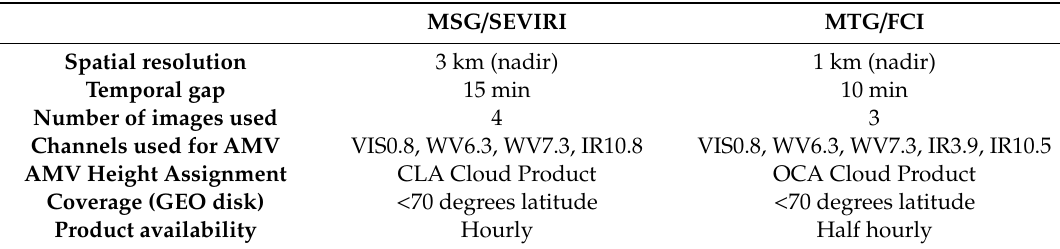
Table 2. Di ff erences between MSG (Meteosat Second Generation) / SEVIRI (Spinning Enhanced Visible and InfraRed Imager) and Meteosat Third Generation (MTG) / FCI (Flexible Combined Imager) AMV product